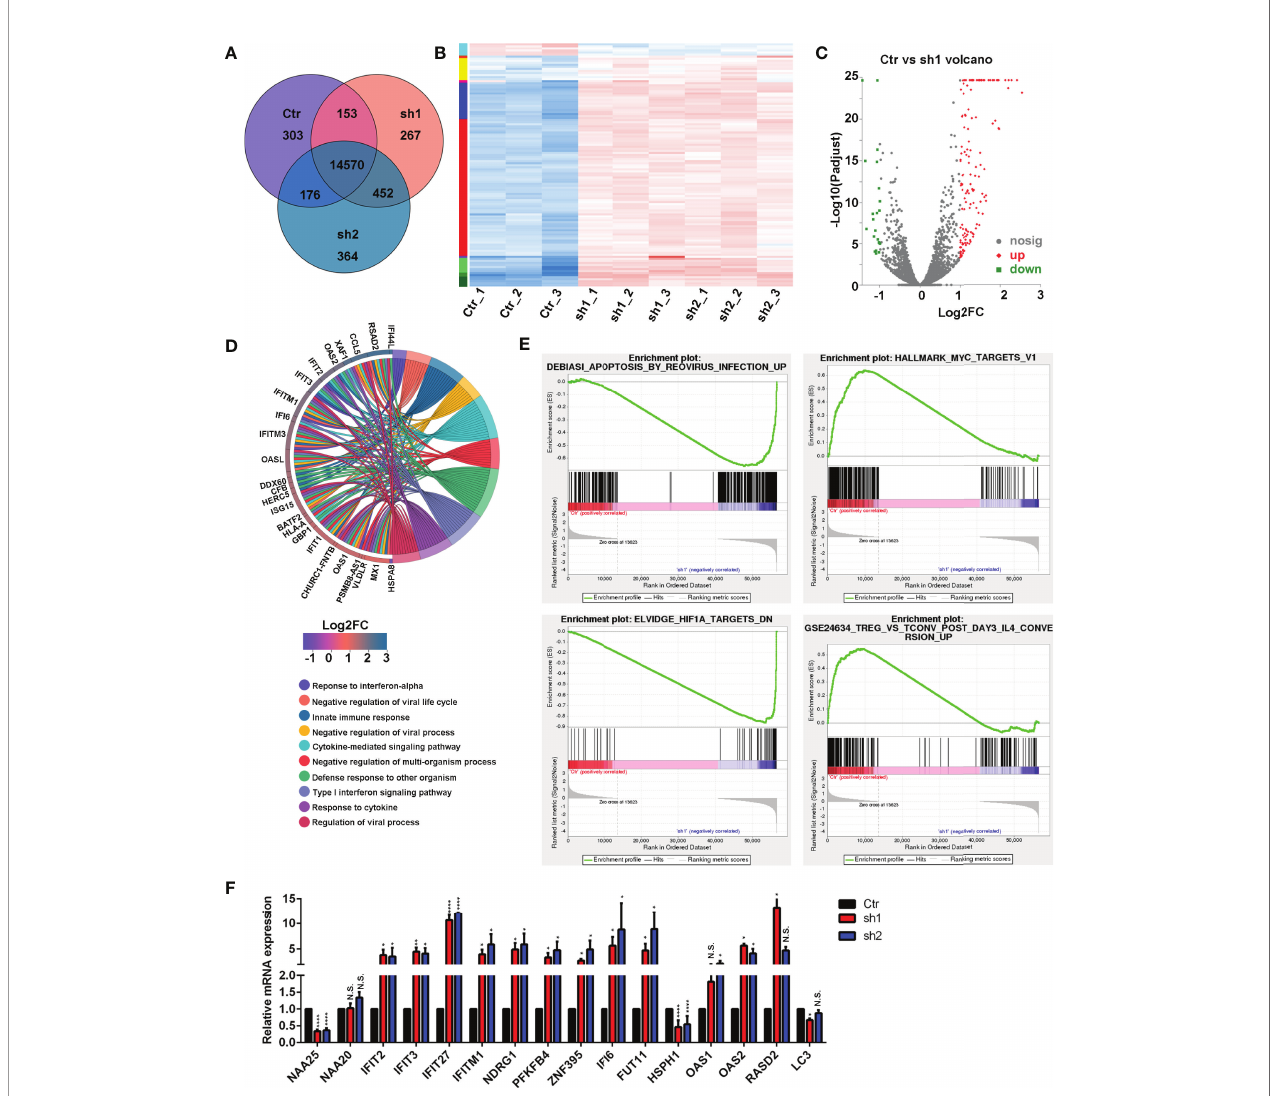
FIGURE 3 | RNA-seq analysis in the NAA25-de fi cient T47D cells. (A) Venn diagram analysis of gene or transcript expression among the Ctr group and shRNA groups. (B) Differentially expressed gene (DEG) heatmap analysis. Blue indicates downregulated genes. Red indicates upregulated genes. (C) Volcano plot showing the DEG in the Ctr group and the sh1 group. (D) GO term analysis between the Ctr group and the sh1 group. (E) Gene set enrichment analysis (GSEA) to analyze DEG between the Ctr group and the sh1 group. (F) RT-qPCR analysis to validate DEGs after NAA25 knockdown in the T47D cells. The data shown here are representative of at least 3 independent experiments. N.S. p > 0.05; * p < 0.05; ** p < 0.01 and **** p <